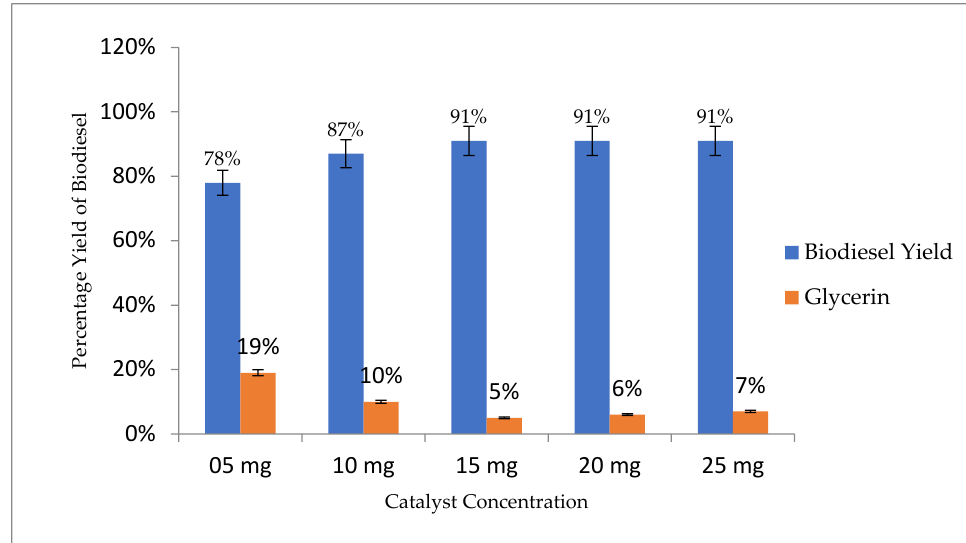
Figure 4. The effect of catalyst concentration on biodiesel yield.